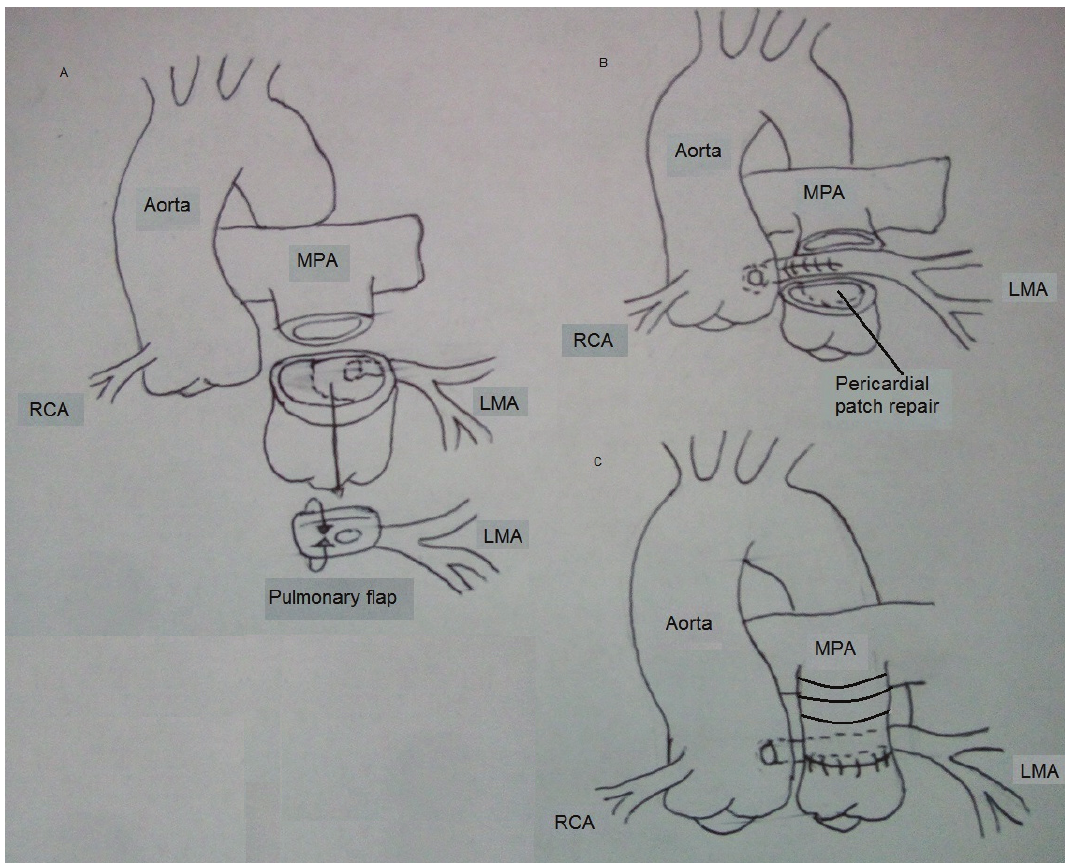
Figure 3. A – LMA taken from the MPA and reconstructed as a tubular structure with bovine pericardium. B – LMA anastomosis to the Ao as in a normal position, MPA reconstructed with a pericardial patch. C – MPA reconstructed with a Dacron